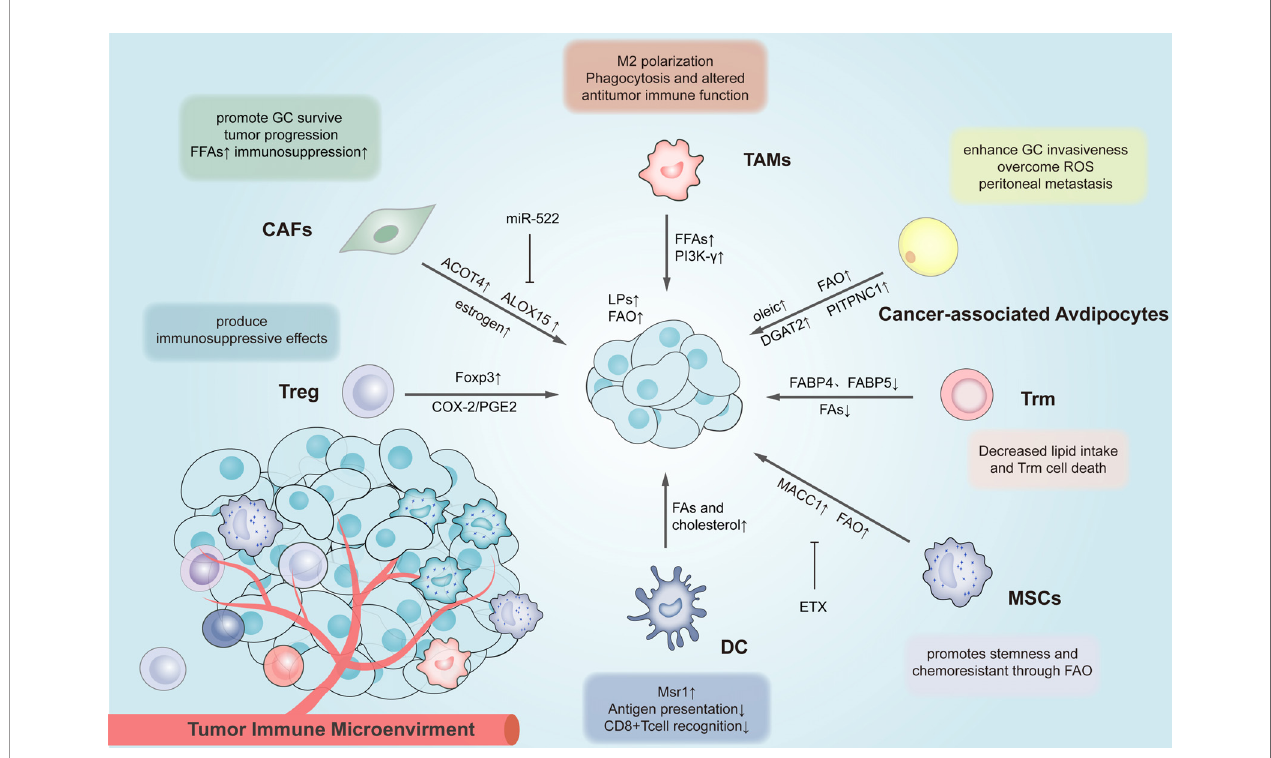
FIGURE 4 | Lipid reprogramming in the tumor microenvironment affects the inter-cellular lipid metabolism and drug resistance of immune cells. Different immune cells in the TME of gastric cancer have different lipid metabolism changes, thus affecting their functions. The above metabolically reprogrammed immune cells exert different effects on GC. MSCs, Mesenchymal stem cell; CAFs, Cancer-associated fi broblasts; FFAs, free fatty acids; MACC1, Metastasis Associated in Colon Cancer 1; PITPNC1, Phosphatidylinositol transfer protein represents cytoplasmic 1; ACOT4, The acyl-CoA thioesterase 4; ALOX15, arachidonate lipoxygenase 15; Treg cells, regulatory T cells; TAMs, tumor-associated macrophages; DCs, dendritic cells; TAMs, tumor-associated macrophages; Trm cell, tissue-resident memory T